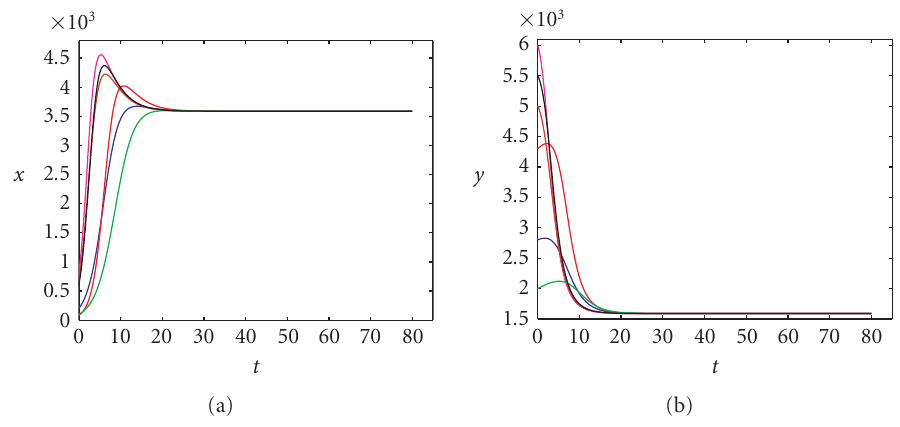
Figure 3.15. Time histories of response of the dynamical system with c = 1 . 2, and the parameters shown in Figure 3.13(b). (a) Terrorist population versus time. (b) Susceptible populations versus time. Note the much larger steady state terrorist population as compared to Figure